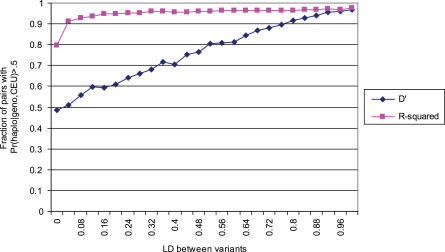
Consistency of HuRef Haplotypes with HapMap DataHaplotypes inferred from the HuRef data are strongly consistent with HapMap haplotypes. The probability in the HapMap CEU panel of the observed genotypes being phased as per the HuRef haplotypes is high for variants in strong LD (as measured either by D′ or r
2).